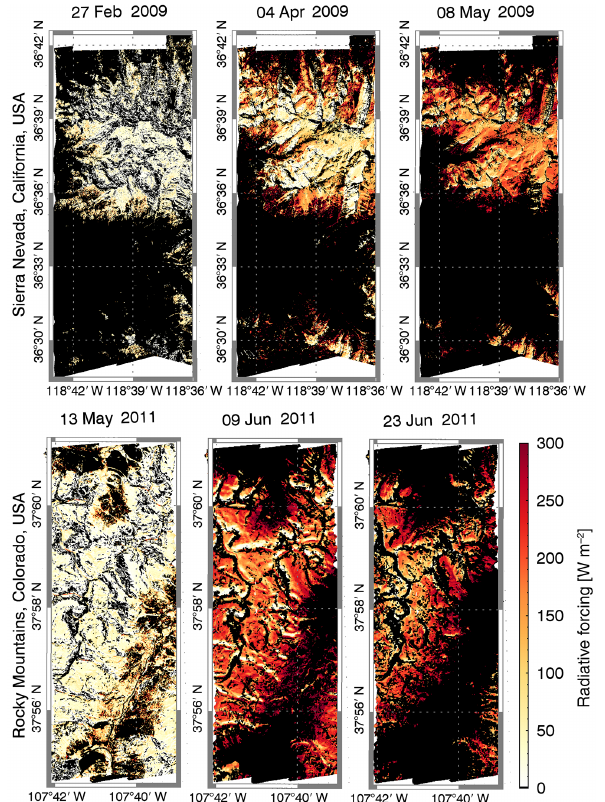
Figure 6. Same as Fig. 4 but for snow radiative forcing. Figure 7. Time series of snow cover, albedo, grain size and impu- rity radiative forcing in the Sierra Nevada, CA, USA, in 2009 (up- per panel) and in the Rocky Mountains, CO, USA, in 2011 (lower panel). The snow cover is normalized by the size of the study area and the other values represent the average value per date surrounded by the corresponding standard